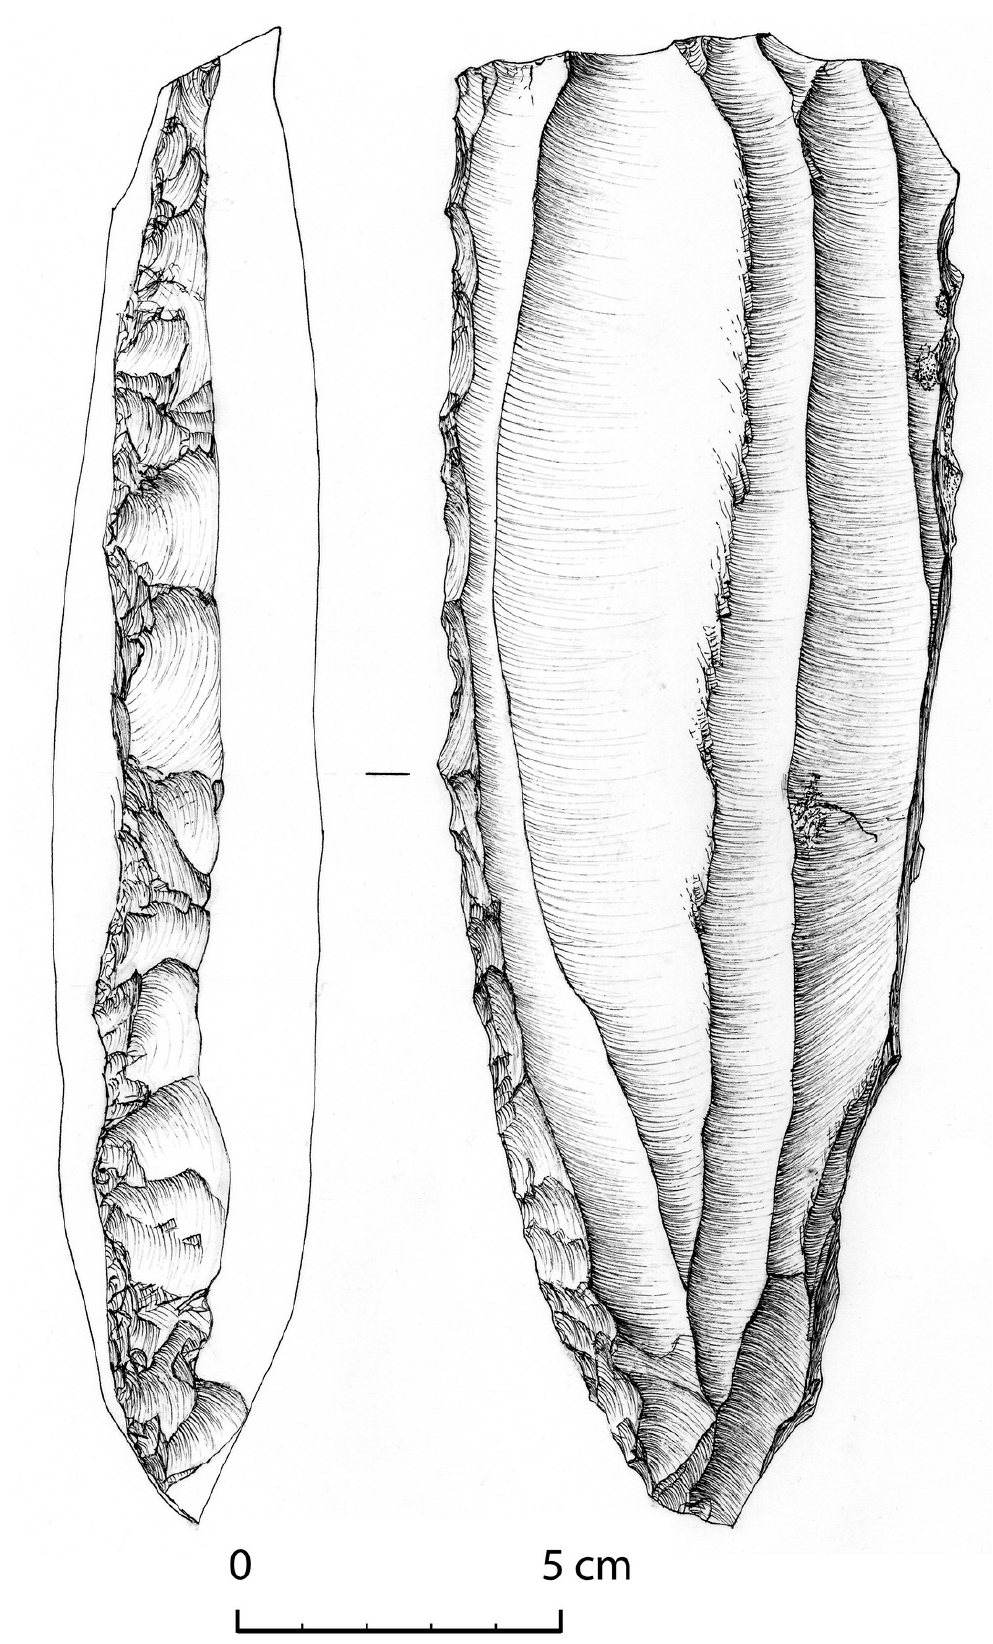
Figure 25. Spiennes, Camp-à-Cayaux. Exhausted blade core, found at the bottom of the deep mines (1982